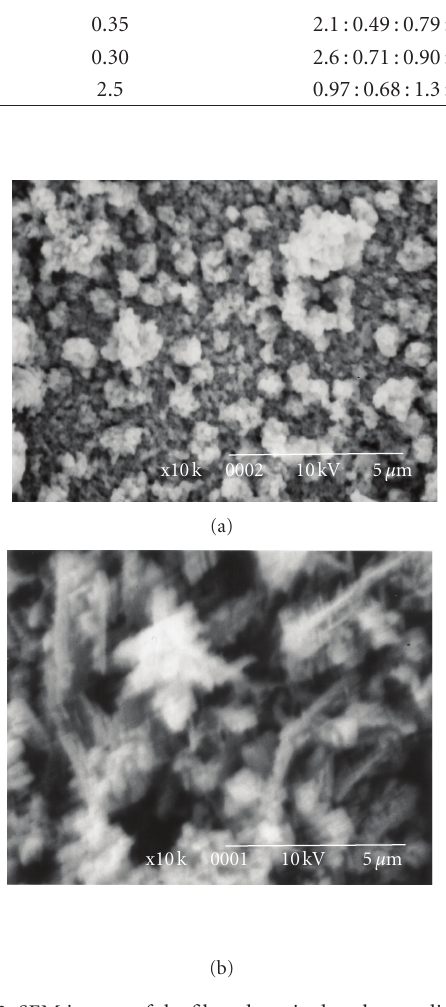
Figure 3: SEM images of the films deposited under condition 1 (a) and condition 5 (b). The former one is denser than the